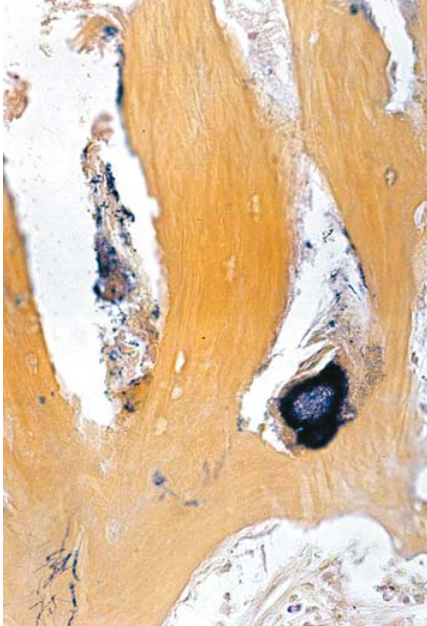
FIGURE 2- Dentinal tubules with several gram-positives and gram-negatives bacteria, Brown & Brenn - 1000X